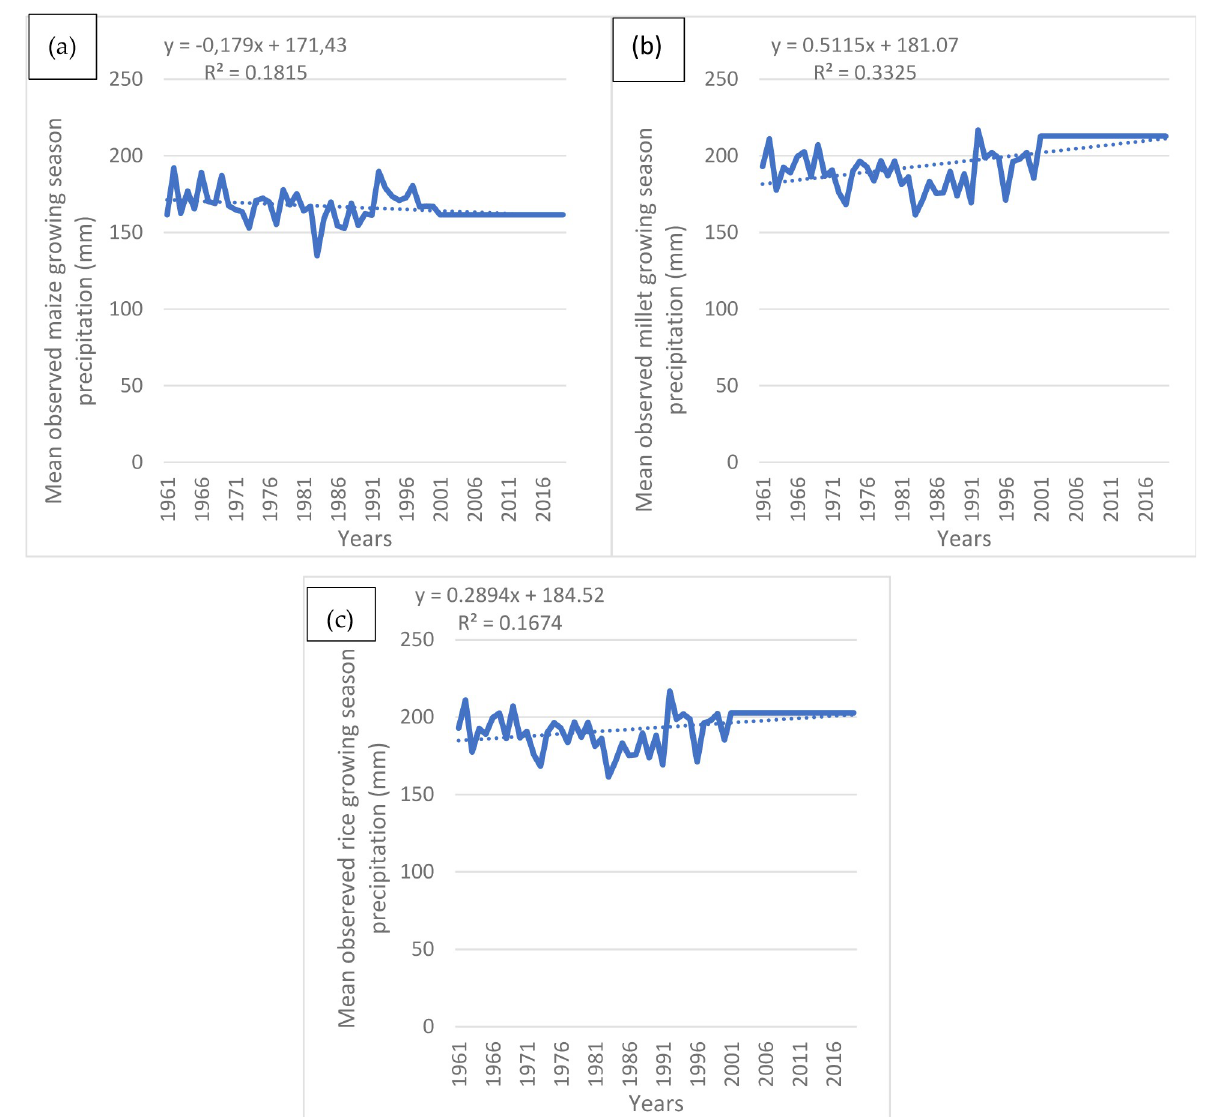
Fig 7. National scale observed (a) Maize growing season precipitation, (b) Millet growing season precipitation and (c) Rice growing season precipitation for Cameroon. Source: Authors’